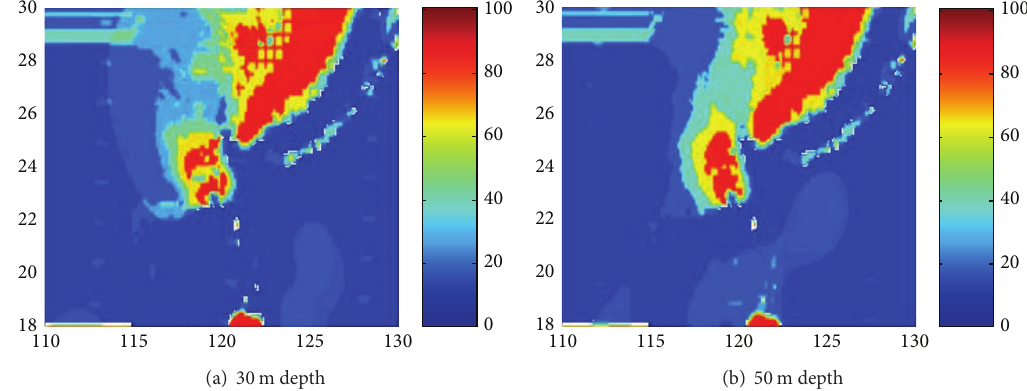
Figure 3: Safety situation